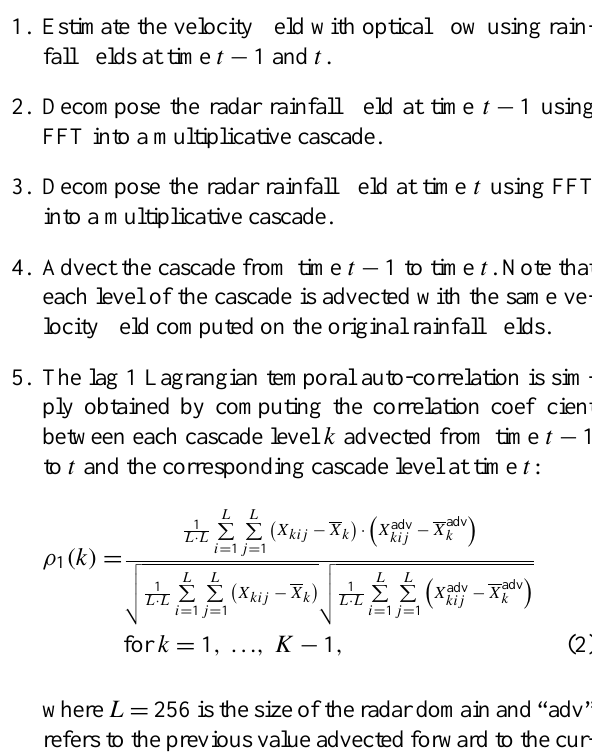
The Lagrangian lag 1 temporal auto-correlations at each level of the cascade are estimated as follows (Bowler et al.,